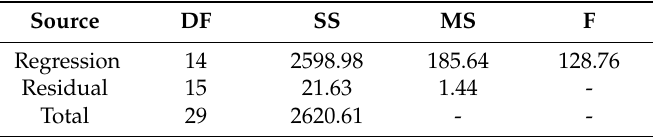
Table 5. ANOVA table for CSOR regression